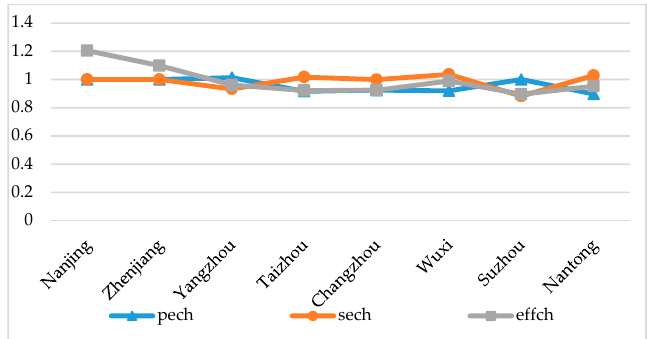
Figure 3. Efficiency change index and index decomposition of EGE of the Yangtze River urban agglomeration in 2007–2016.